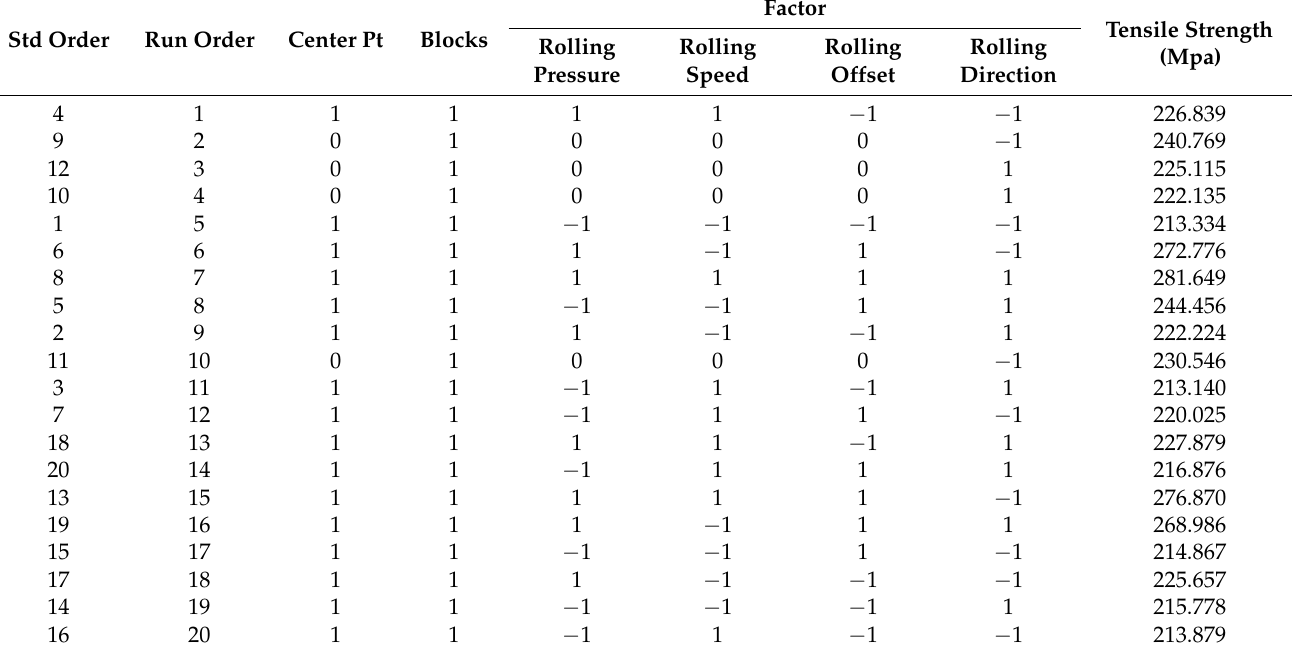
Table 7. Tensile strength test of the deep-rolled workpiece.